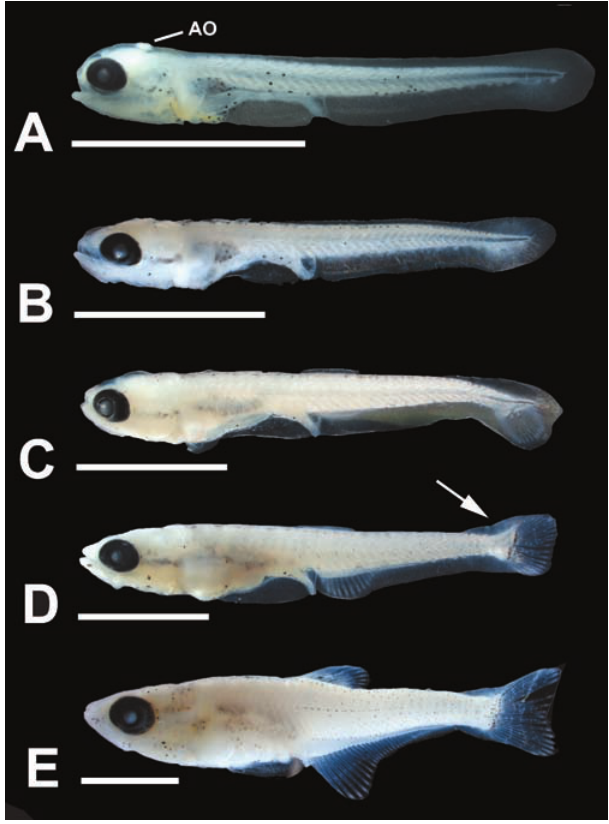
Fig. 3. Larvae and juveniles of Heterocharax macrolepis , lateral view. A: 3.9 mm NL; B: 4.7 mm NL; C: 5.7 mm NL; D; 6.9 mm SL; E: 7.9 mm SL. AO: Attachment organ. Arrow indicates inflexed notochord. Scale bar: 2 mm.